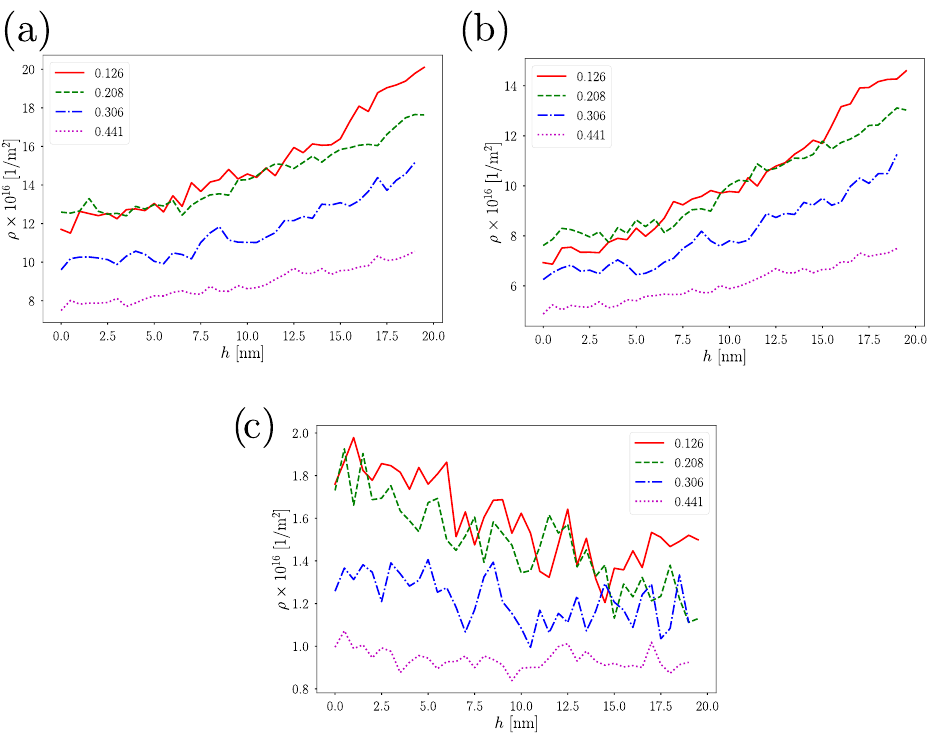
Figure 7. ( a ) Dislocation density as strain function. ( b ) Dislocation density considering only Shockley partial dislocation as a strain function. ( c ) Contribution of sessile dislocations to the dislocation density. By studying the shear strain in the whole sample, we understand the failure modes in this system due to shear accumulation in preferential zone of the nanostructure. As is depicted in Figure 8a, the φ = 0.126 case showed shear strain localized in the contact zone in the grain boundary structure, leading to multiple strained zones located on grain boundaries or in the NS pores. For φ = 0.441, the scenario is quite different since the shear strain at (cid:101) = 0.208 is located in the contact zone and appears as a turned-on region in multiple pores of the NS. More extensive strain origin extended shear zones along the grain boundary structure to drive the grain boundary slip as shown for (cid:101) =